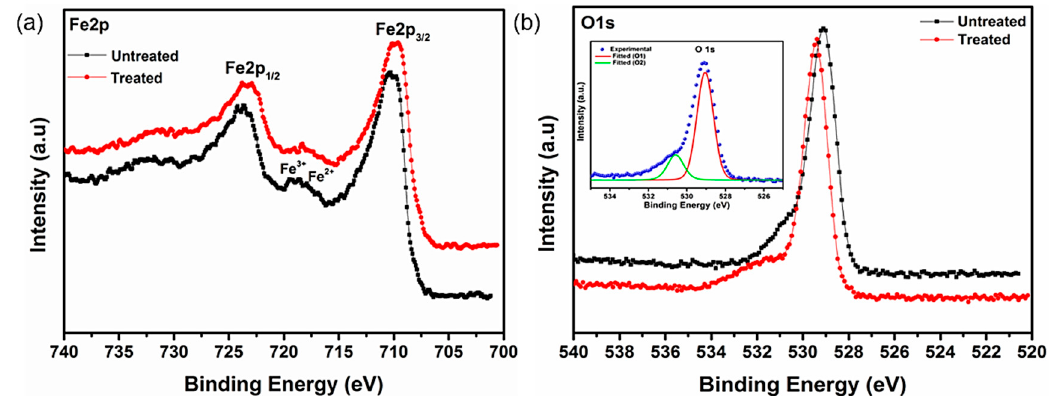
Figure 9. ( a ) Core-level spectra of Fe 2p on the Fe 3 O 4 surface, and ( b ) core-level spectra of O1s Fe 3 O 4 of both bare and SHMP-treated Fe 3 O 4 samples (inset: deconvolution plot of O1s spectra).